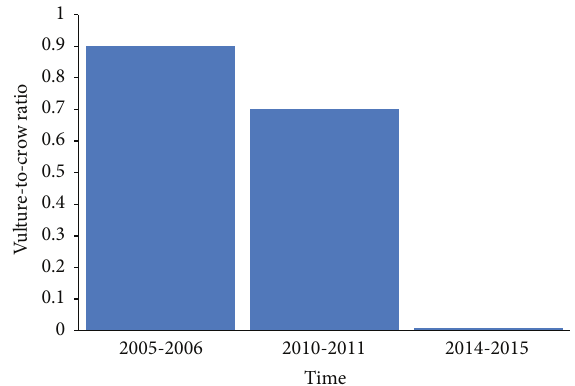
Figure 2: Trends in vulture populations expressed as a ratio to crow populations in simultaneous count of the two species on Legon